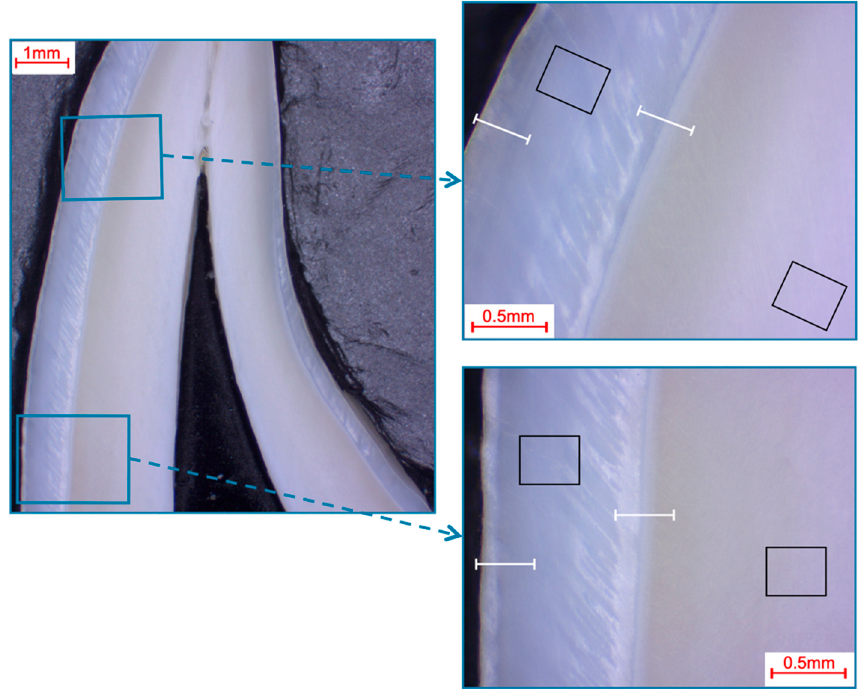
Figure 3. Selection of fields and line scans for the elemental analysis in bovine incisors shown in a photo-microscopic overview. The black rectangles indicate the areas of the 366 µm × 291 µm field scans, while the white lines indicate the approximately 360 µm paths of the line scans. The upper right picture shows the first measurement area (incisal crown), while the lower right picture shows the second measurement area (cervical crown), which was located halfway between the cemento-enamel junction and the first measurement area.